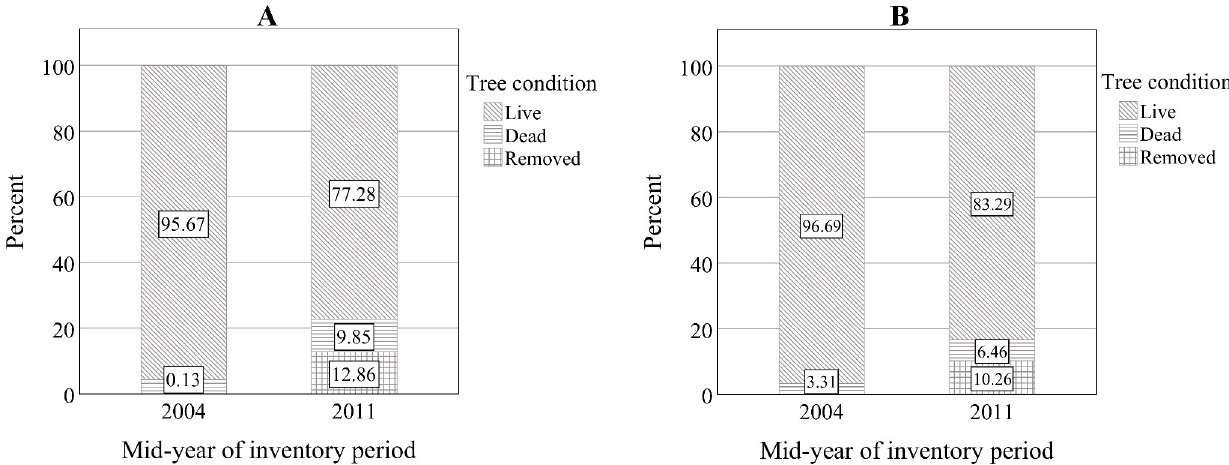
Fig 4. Percent of live, dead, and removed trees for (A) all species and (B) longleaf pine across the plots in 2004 and 2011, where 2004 and 2011 are the centroid-year of first (1997–2010) and last (2003–2018) inventory intervals,